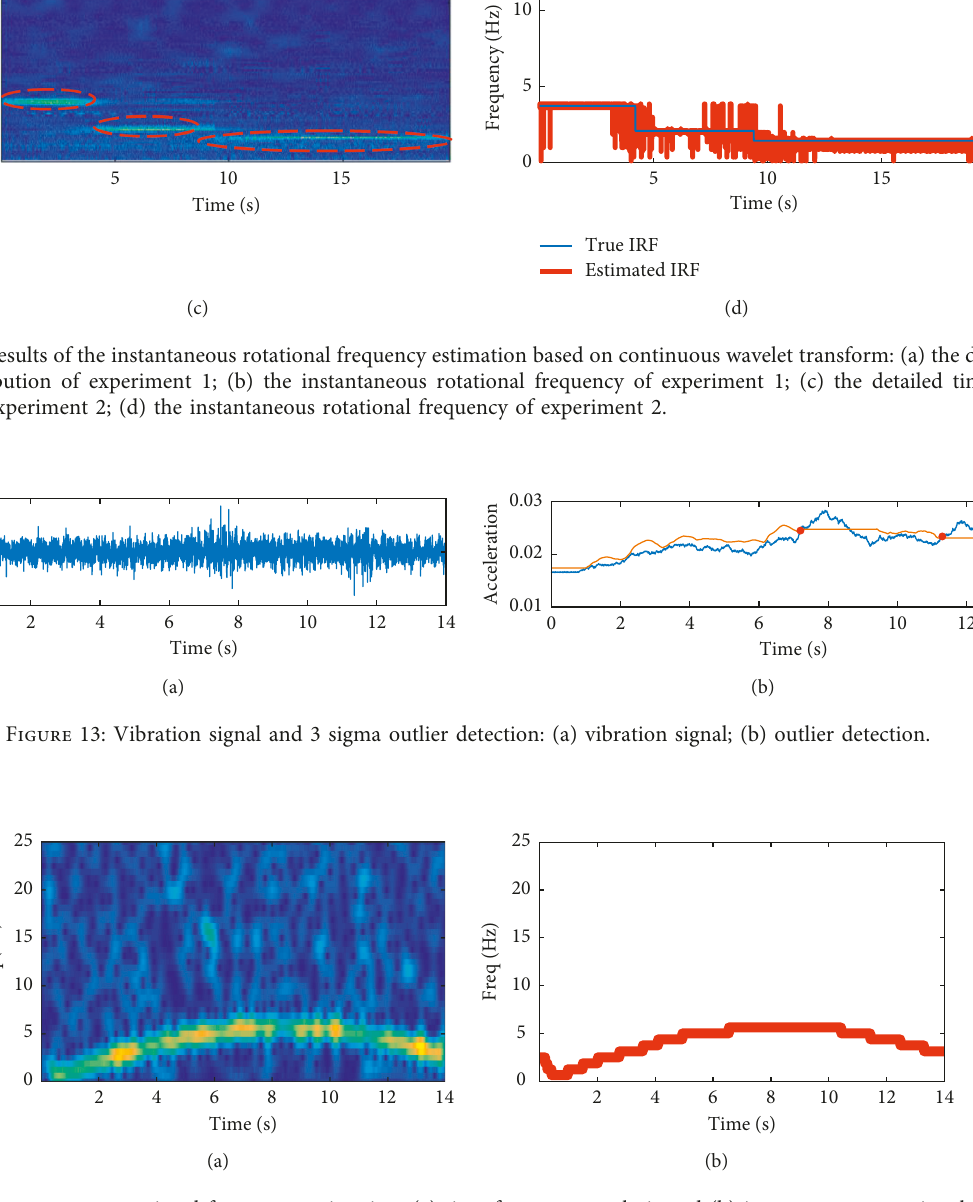
Figure 14: Instantaneous rotational frequency estimation: (a) time-frequency analysis and (b) instantaneous rotational frequency.